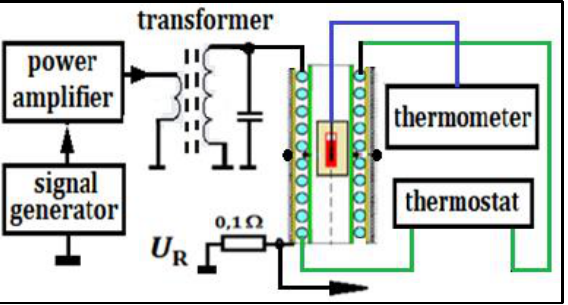
Figure 2. System for generating the alternating magnetic field.